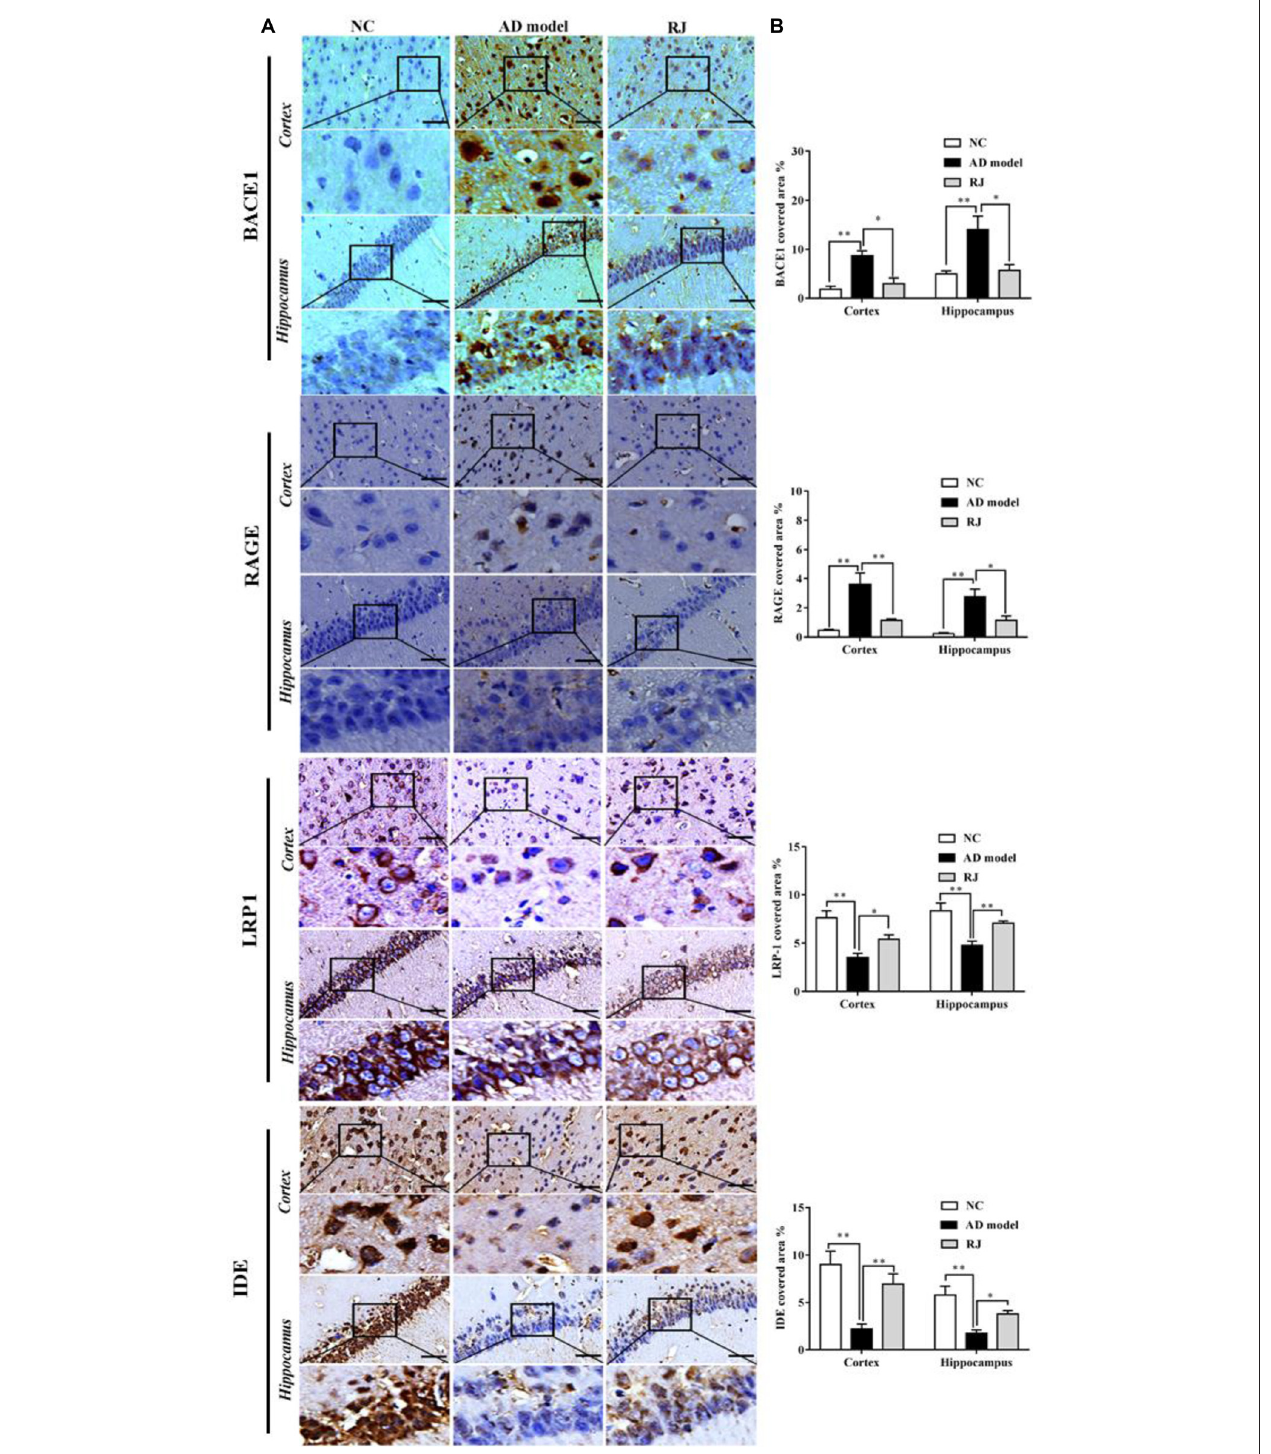
FIGURE 3 | RJ inhibited β -site APP cleaving enzyme-1 (BACE1) and receptor for advanced glycation end products (RAGE) expression levels, and increased lipoprotein receptor-related protein 1 (LRP1) and insulin degrading enzyme (IDE) expression levels, demonstrated by immunohistochemistry. (A) Staining for BACE1, RAGE, LRP1 and IDE using specific antibodies in the brain of the AD model, RJ and normal control (NC) group. Scale bar = 50 µ m. Black squares indicate images with higher-magnification. (B) Quantification of the covered areas of BACE1, RAGE, LRP1 and IDE staining in the frontal cortex and the hippocampus of the three groups, n = 6–8 rabbits per group. Data are presented as mean ± SEM. ANOVA with post hoc Tukey’s test was used. ∗ P < 0.05, ∗∗ P < 0.01 vs. the AD model group.